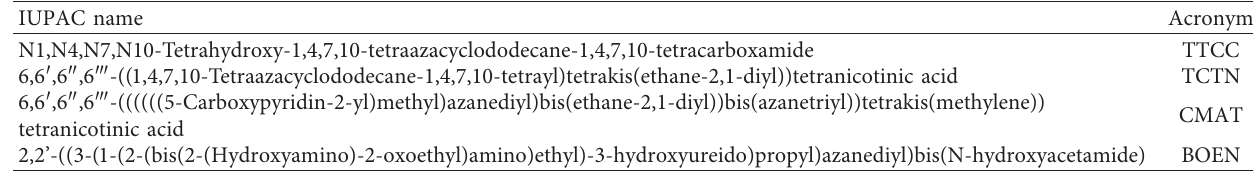
Table 1: IUPAC names of designed novel chemicals.